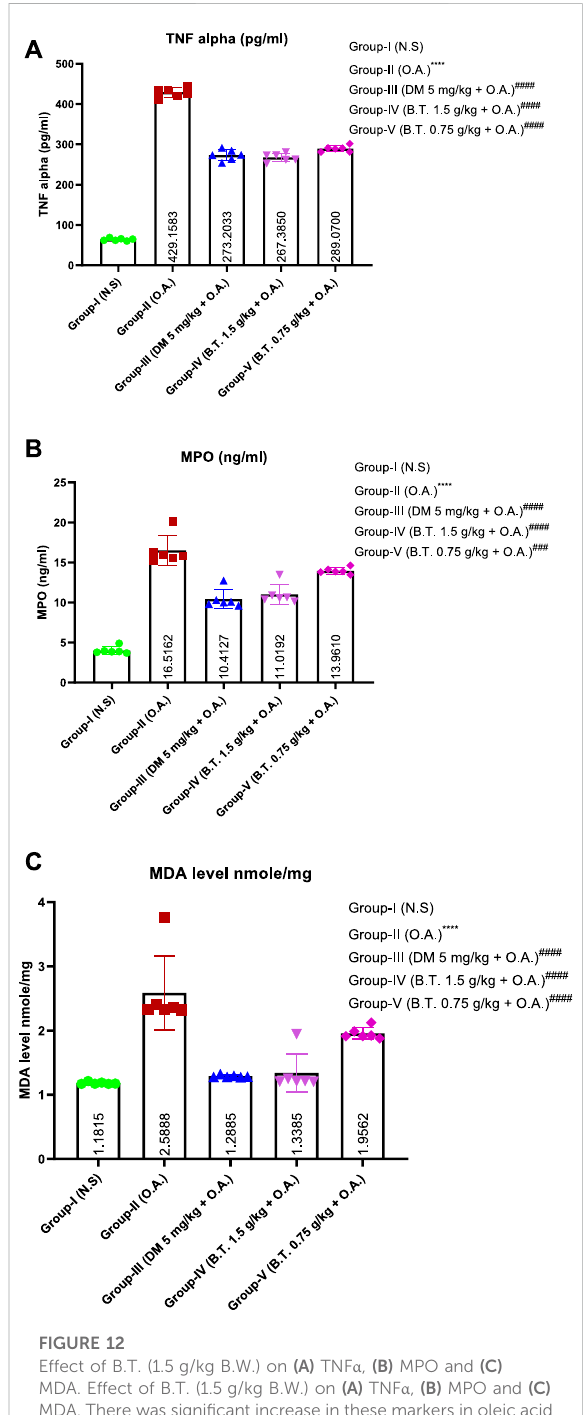
FIGURE 12 Effect of B.T. (1.5 g/kg B.W.) on (A) TNF α , (B) MPO and